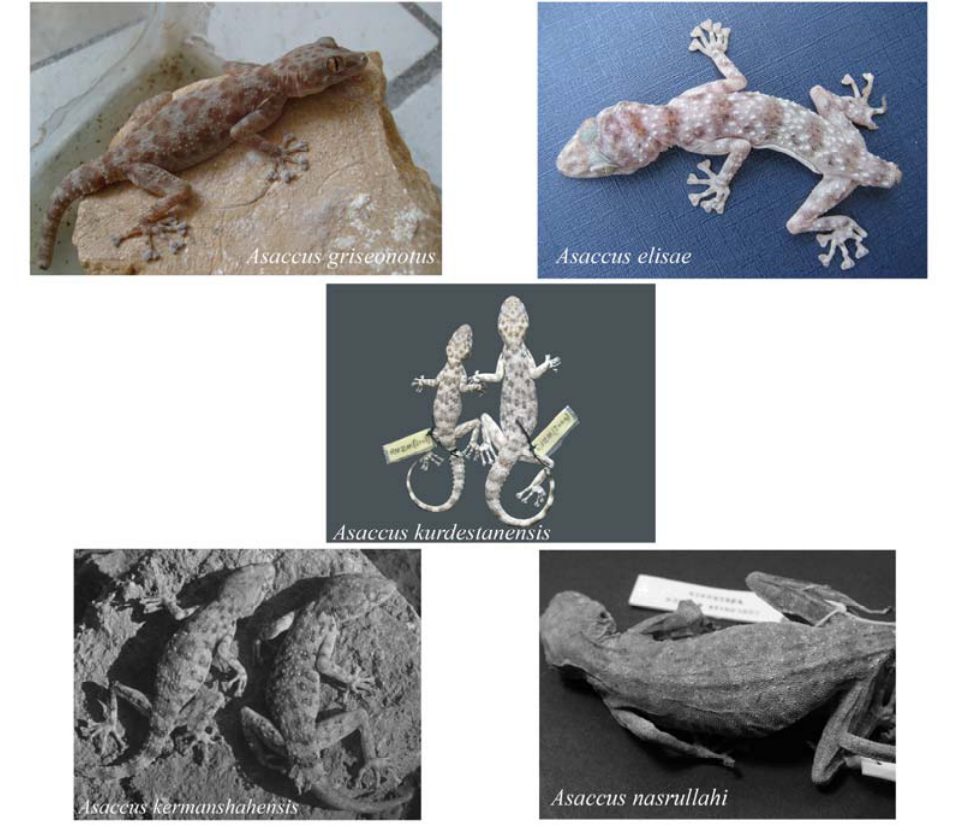
F IG . 7 . Differences in dorsal pattern of different Iranian Asaccus species (note the differences in dorsal